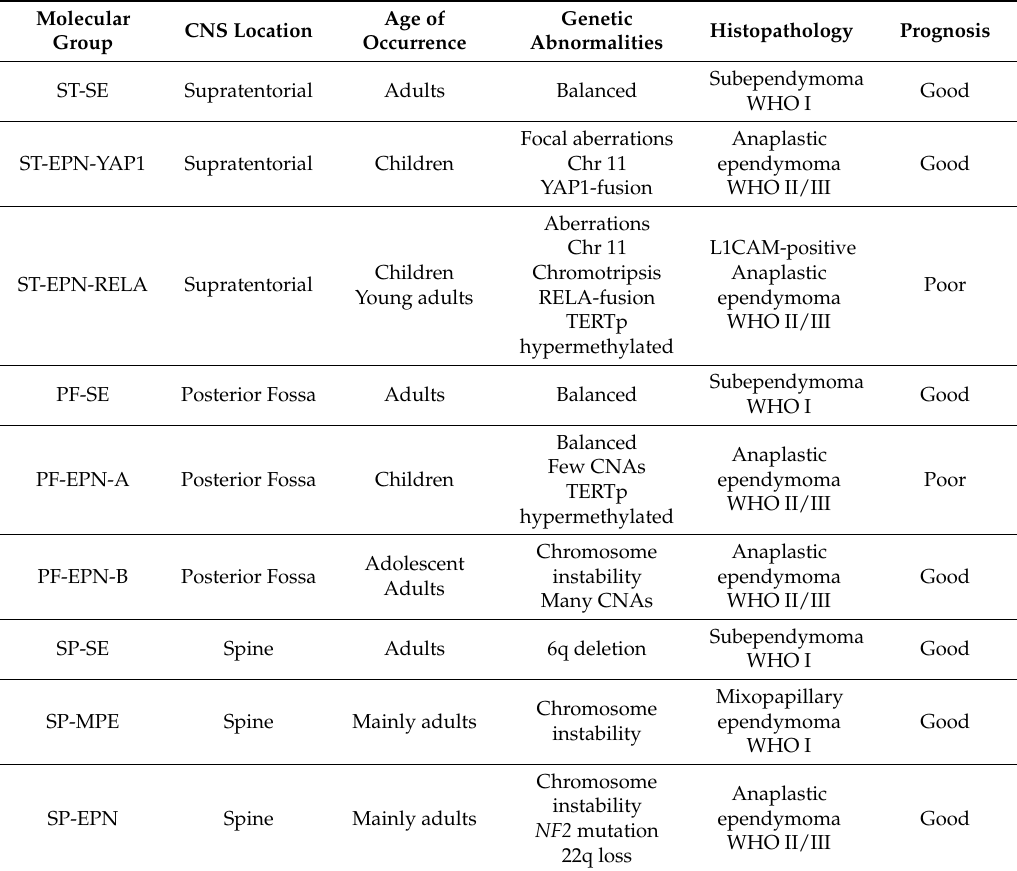
Table 7. Main somatic genetic, epigenetic, and clinical features of nine molecular subgroups of ependymomas, identified by methylation